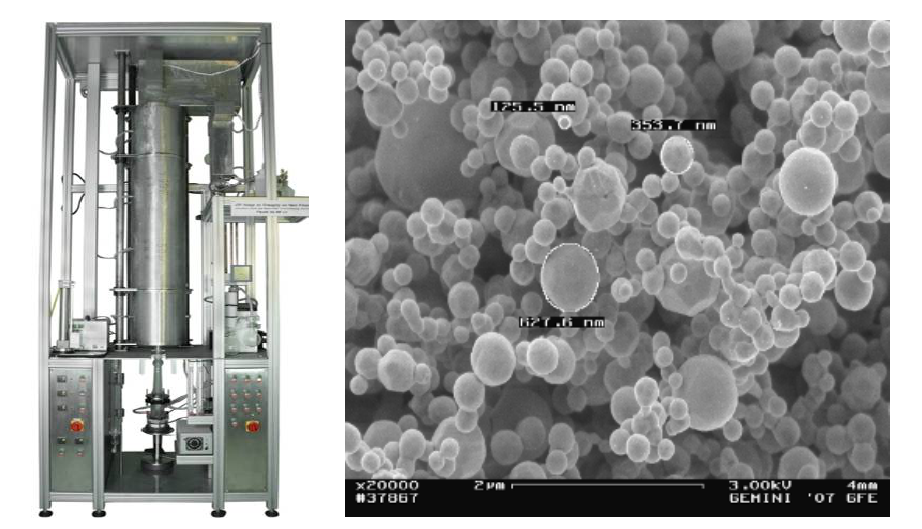
Figure 8 – USP-Synthesis at the IME, RWTH University/SEM analysis of nanosilver Slika 8 – USP-sinteza na IME, RWTH Univerzitetu/SEM analiza od